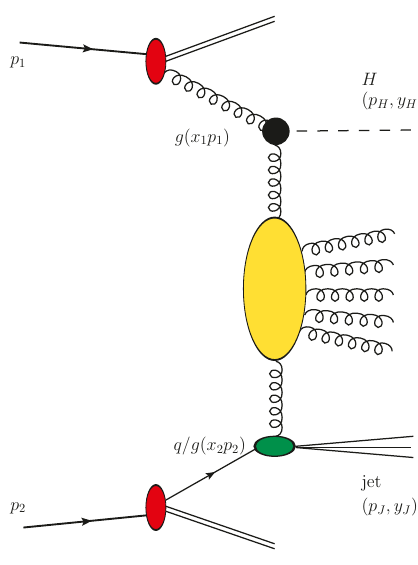
Figure 1 . Schematic description of the process (2.1) in the